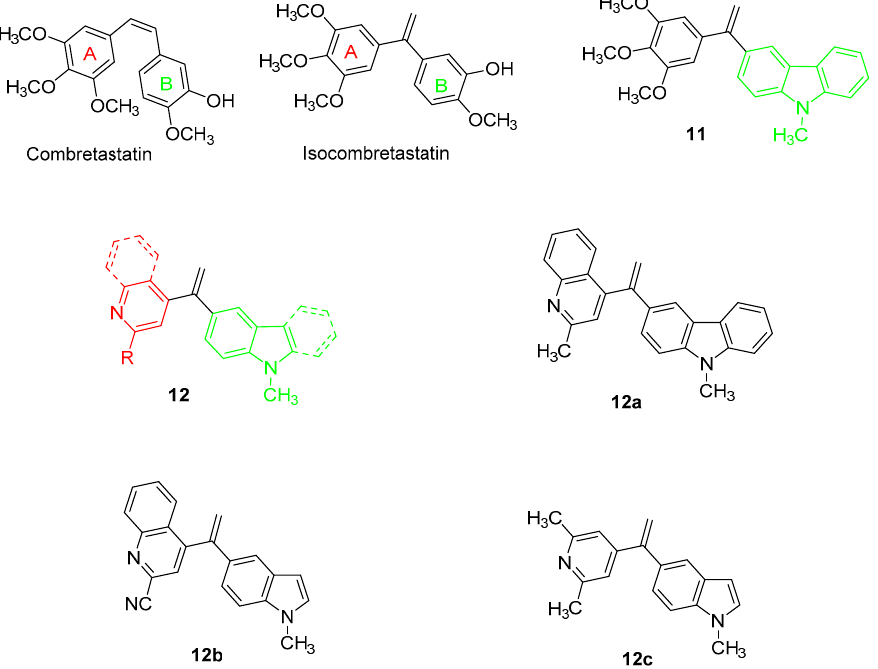
Chart 4. Indole-based tubulin polymerization inhibitors ( 11 – 12 ) in GBM.